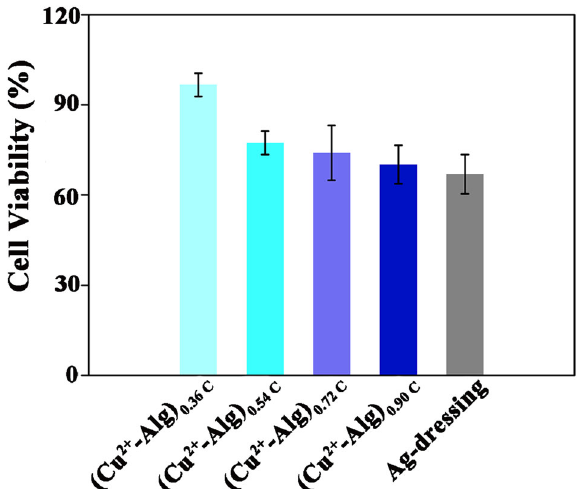
Fig. 5 The biocompatibility estimation of fi lms using a MTT viability assay. HUVECs cells were cultured in the presence of different fi lms for 1 day. HUVECs cell viability assays provide evidence that all the Cu 2 + -Alg fi lms have comparable or better cell compatibility than commercial Ag